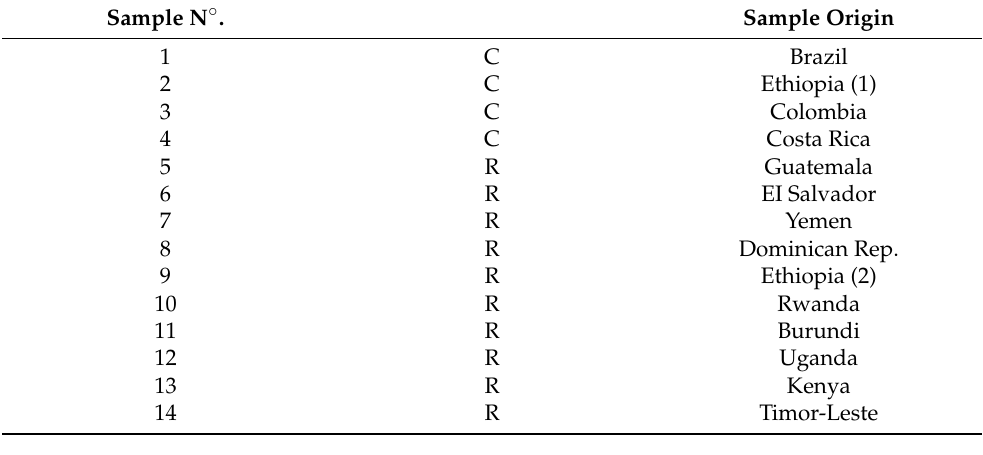
Table 1. Espresso coffee origins and labels. C: capsules; R: roasted coffee beans. Sample N ◦ .